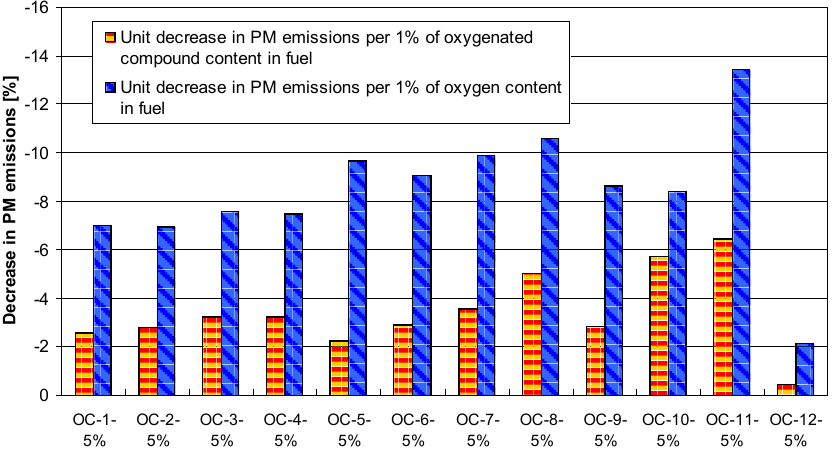
Figure 5. Unit effect of oxygenate and oxygen content in fuel on PM emissions over the NEDC from a test car with fuels containing individual oxygenates at a concentration of 5% v / v compared to running on conventional diesel fuel.